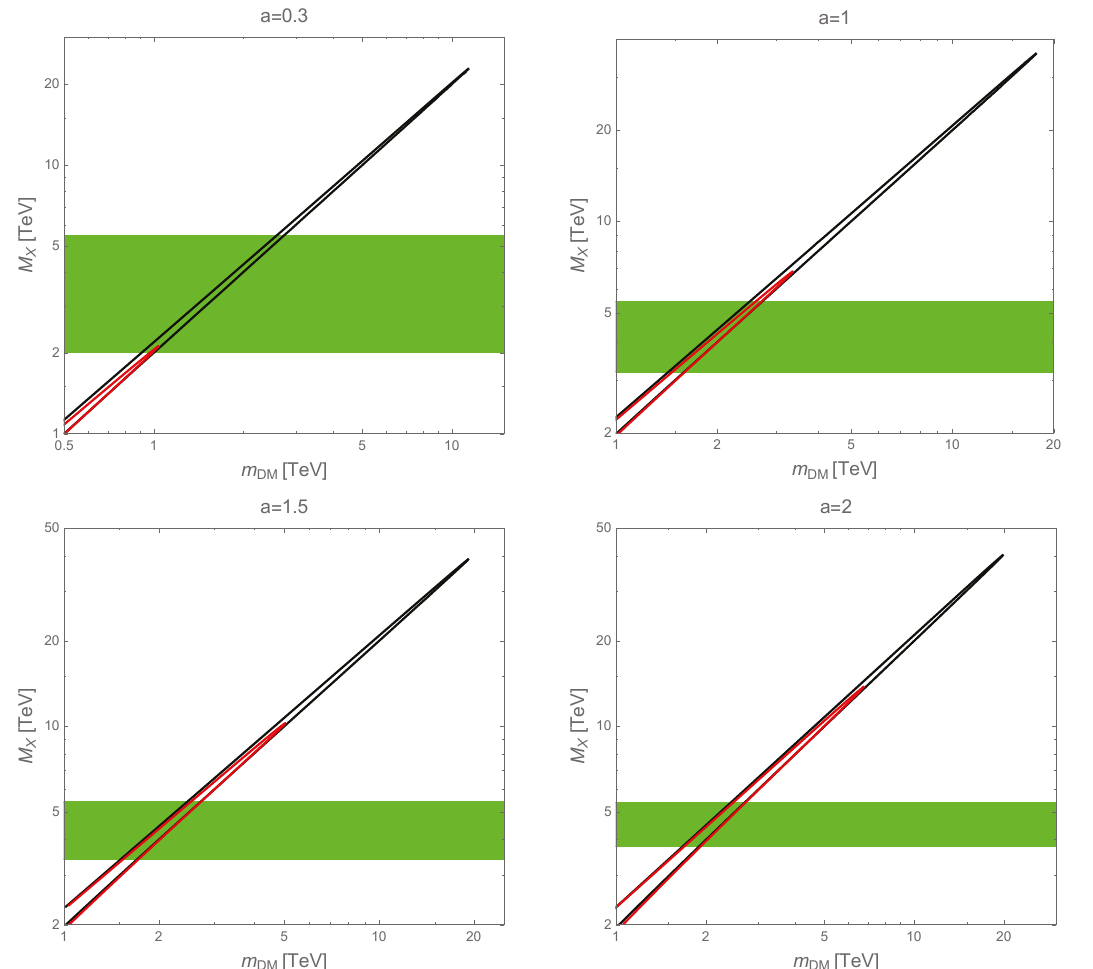
Figure 5 . The parameter region to reproduce the observed DM relic density for various a values. The black and red solid lines correspond to the results for g BL | which Ω DM h 2 = 0 . 12 is reproduced. The green shaded regions depict the ranges of M X which simultaneously satisfy the perturbativity condition and the LHC Run-2